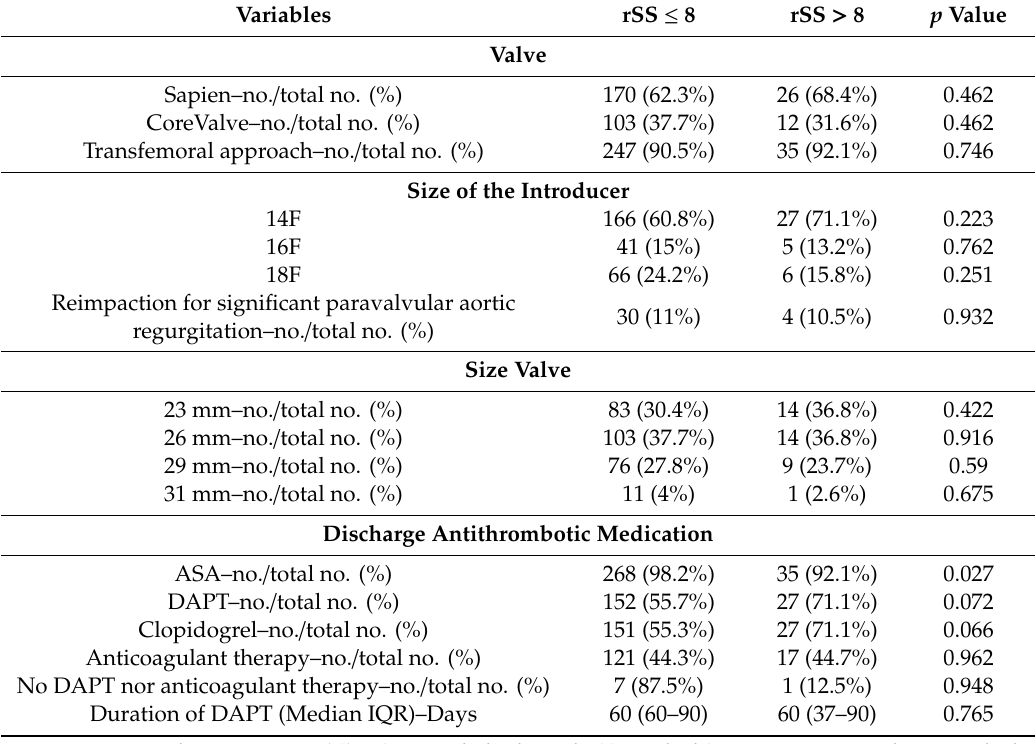
Table 2. Procedural TAVR characteristics according to residual SYNTAX score